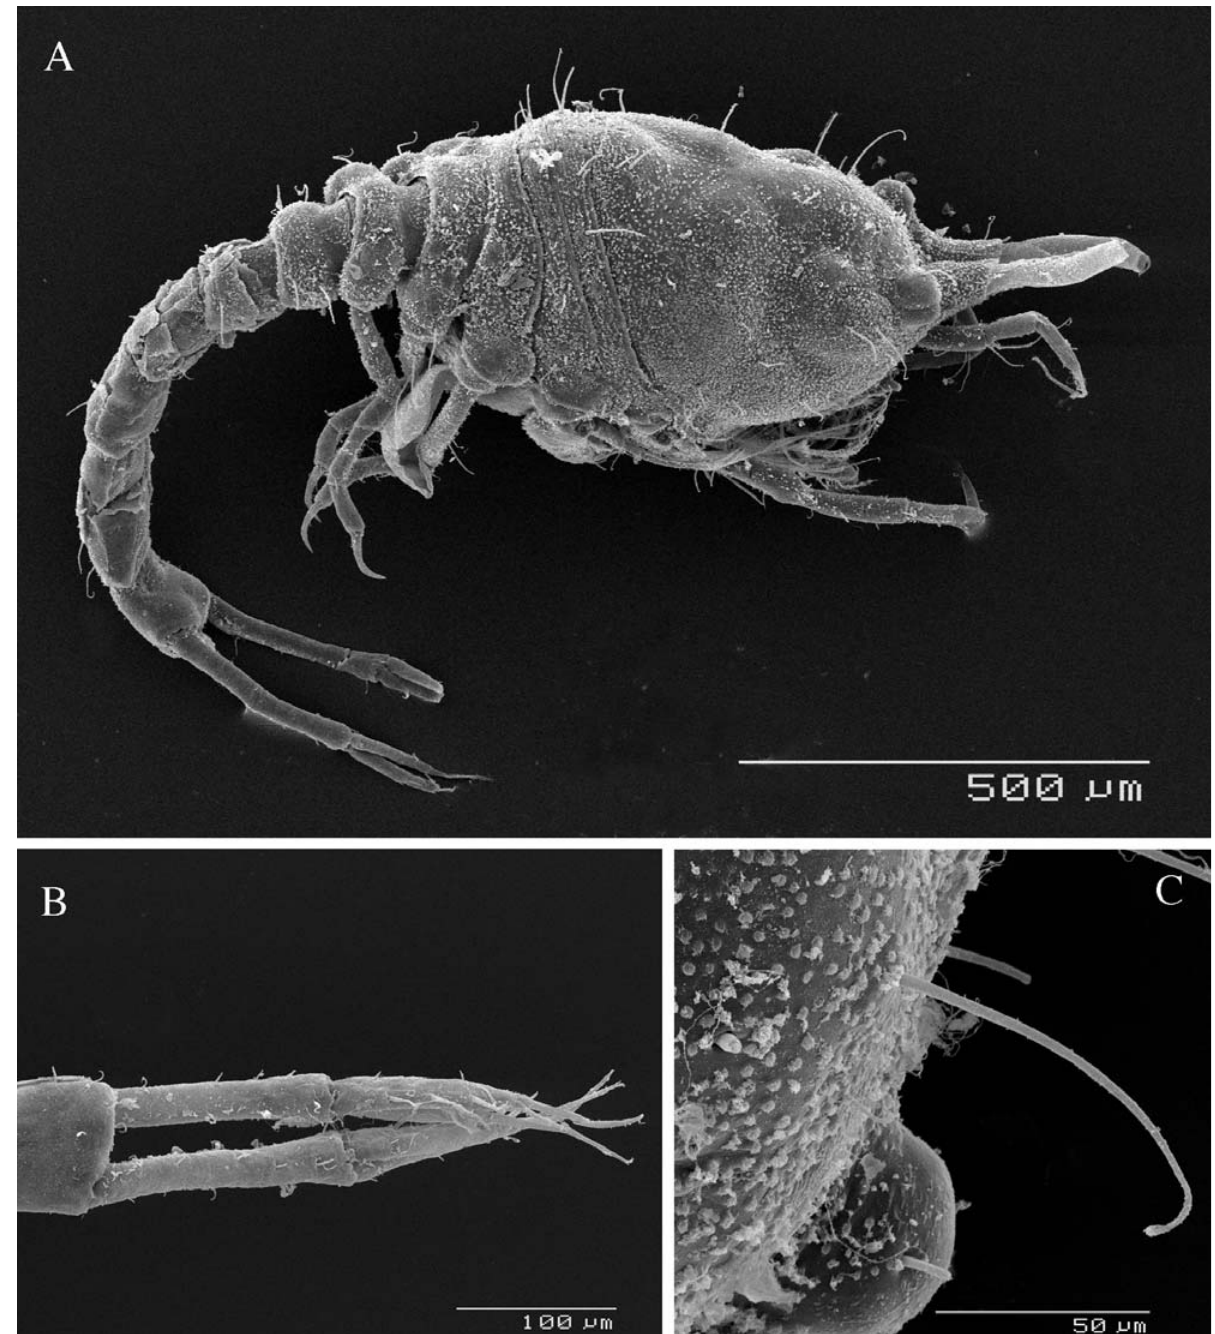
Fig. 1. – Scherocumella gurneyi (Calman, 1927), female, SEM photographs: A, whole animal in lateral view; B, uropods; C, microstructure of the carapace cuticle near the eye showing microtubercles and a long simple